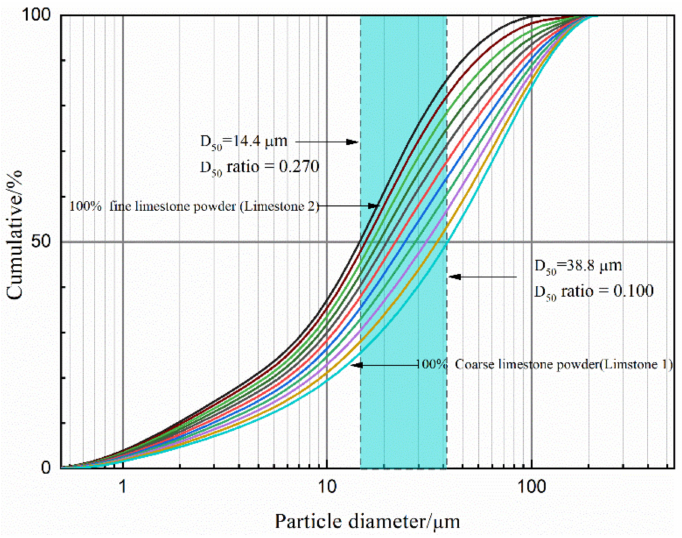
Figure 4. The particle size distribution of the mixed limestone powders of limestone 1 and limestone 2.